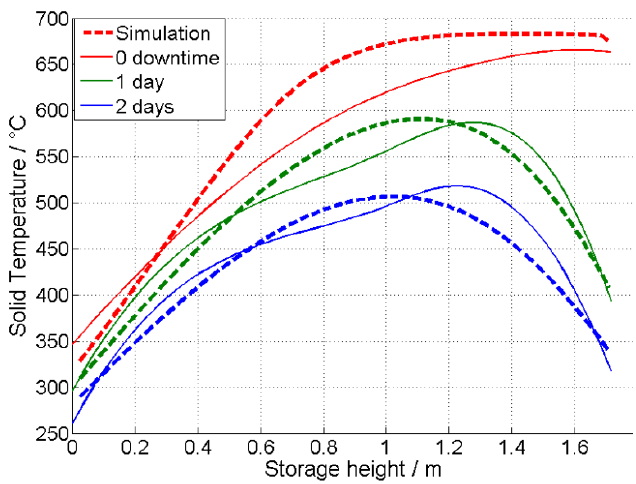
Figure 11. Downtime behavior of the fully charged experimental, 21 March conditions.